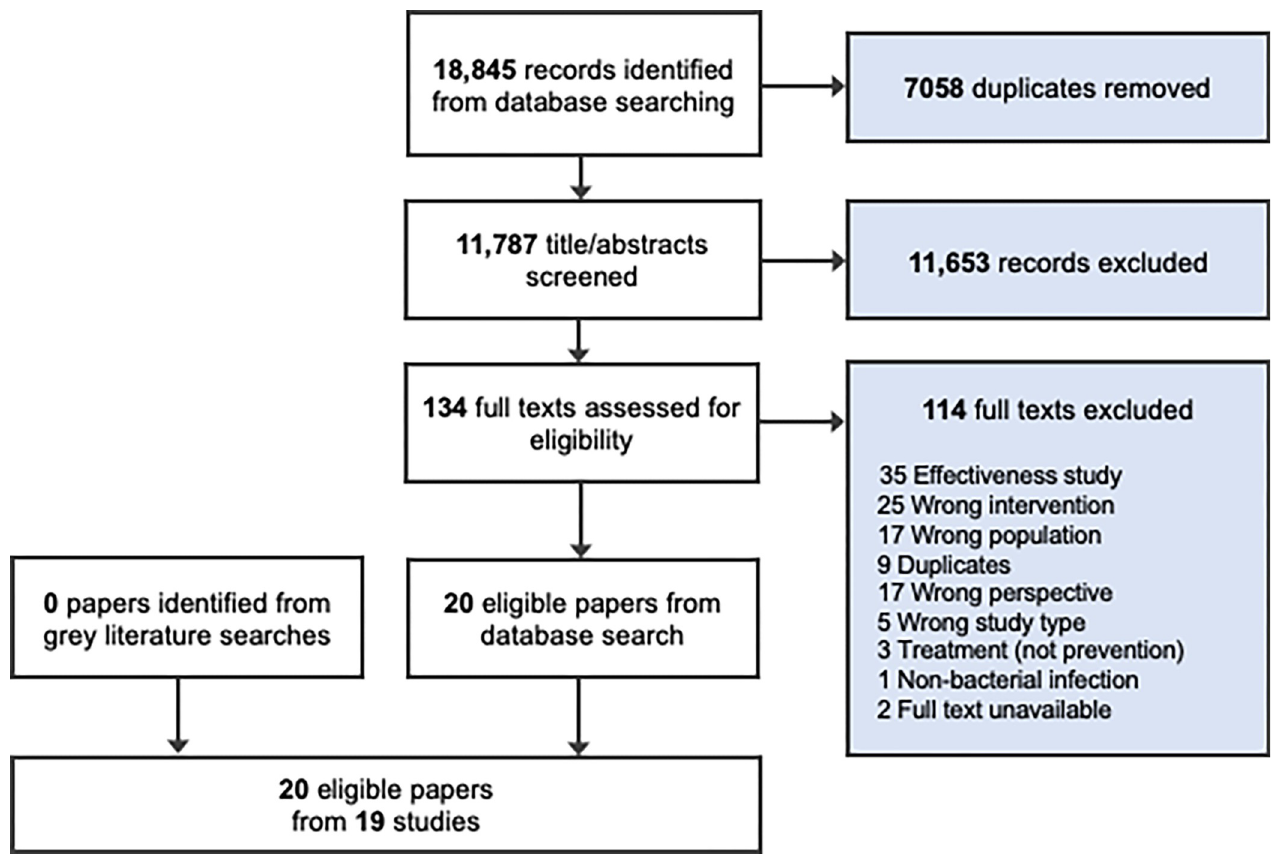
Fig 1. PRISMA flow